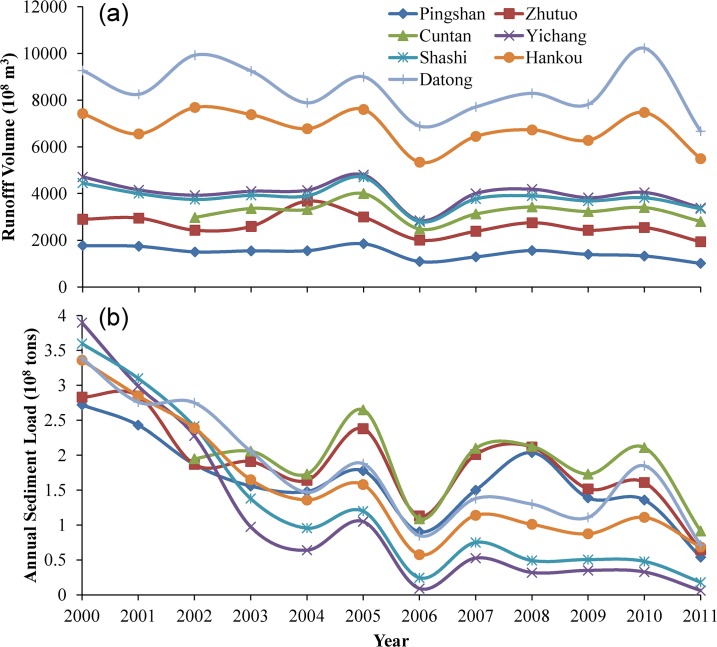
Time series of runoff volume (a) and sediment yield (b) measured at seven hydrological stations along the main stream of Yangtze River.